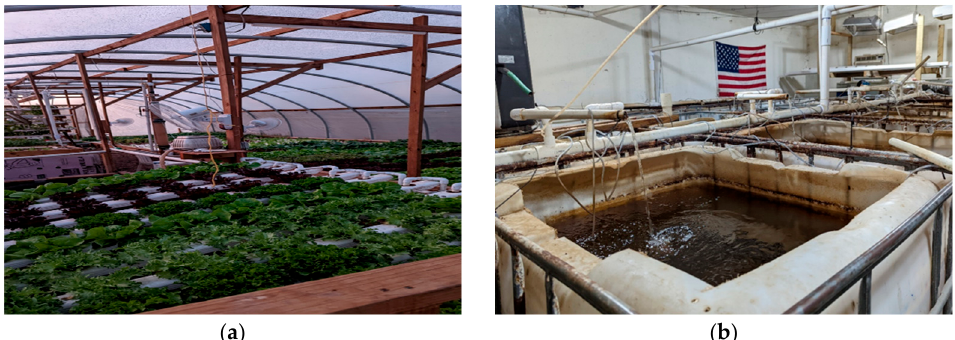
Figure 1. ( a ). set-up of the plant bed which was used for producing lettuce and other greens; and ( b ). a set-up of an array of interconnected fish tanks which served as a nutrient source for these plants in Texas US Farms, Grimes, TX,